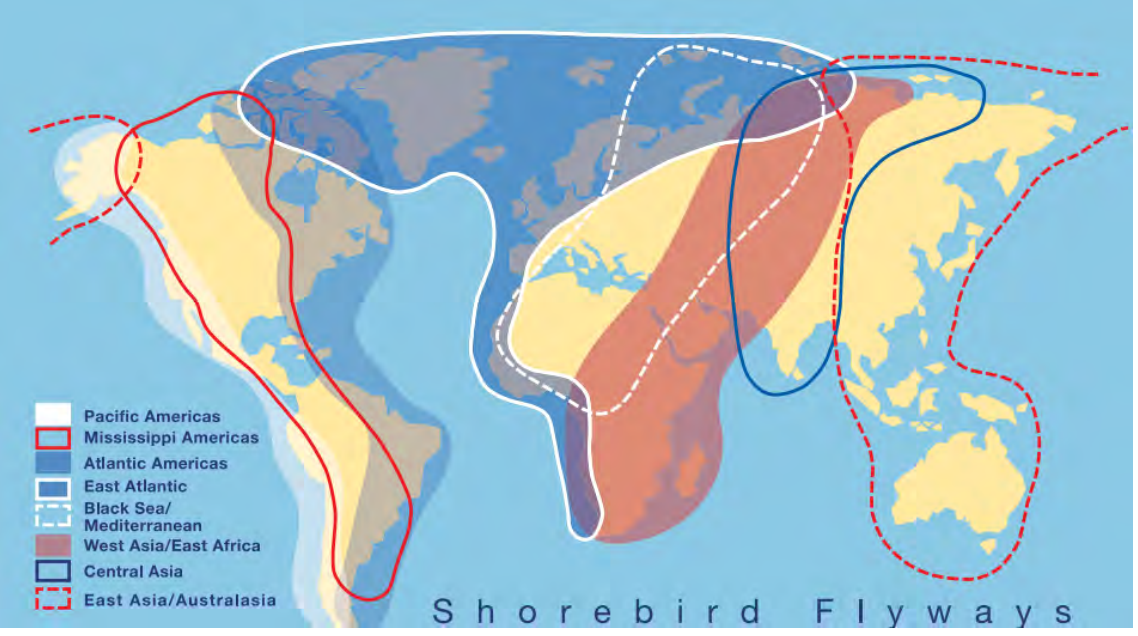
Figure 3. The eight broad flyways of waders/shorebirds. Source: International Wader Study Group. A more detailed evaluation by Brown et al. 2001 distinguishes five shore bird flyways in North America: Pacific-Asiatic, Intermountain West, Central, Mississippi, and Atlantic. [4].